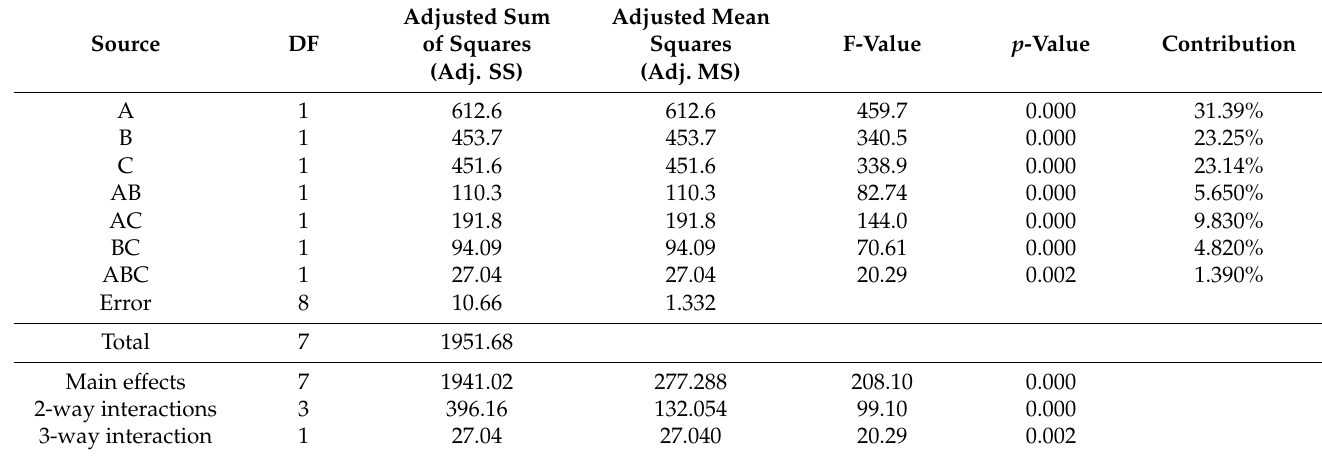
Table 3. Analysis of variance (ANOVA) results for RE calculated using Minitab.